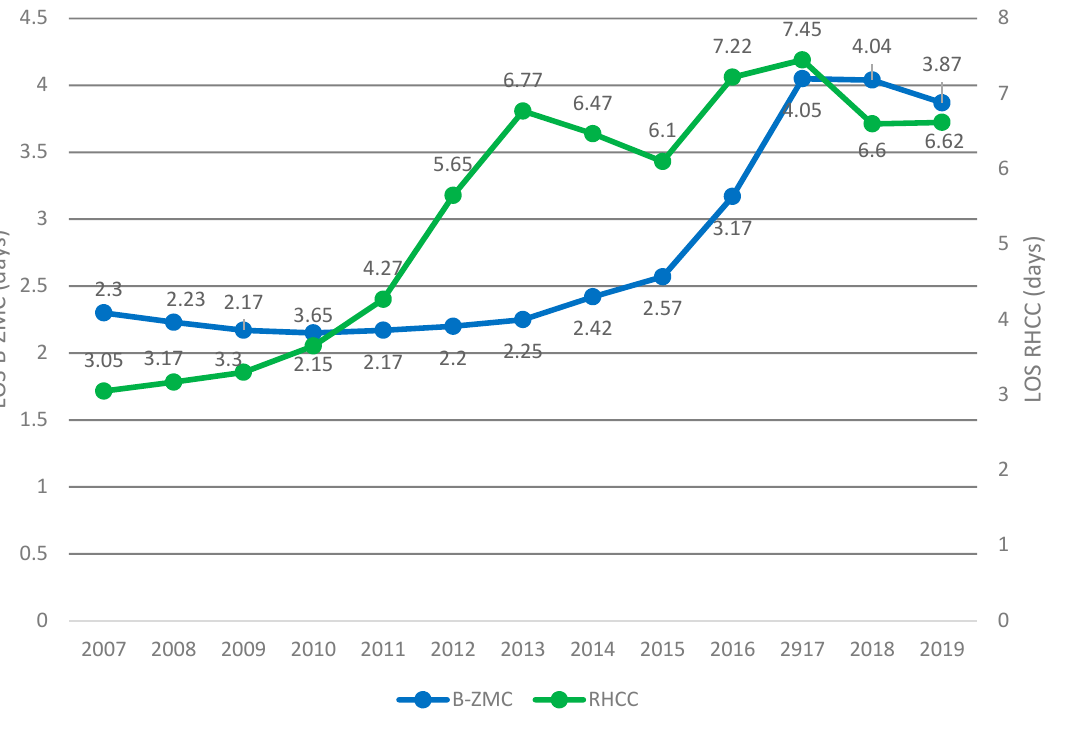
Figure 2. Patients’ length of stay (workup time) until decision is made (presented on a double vertical axis: left, B-ZMC; right,